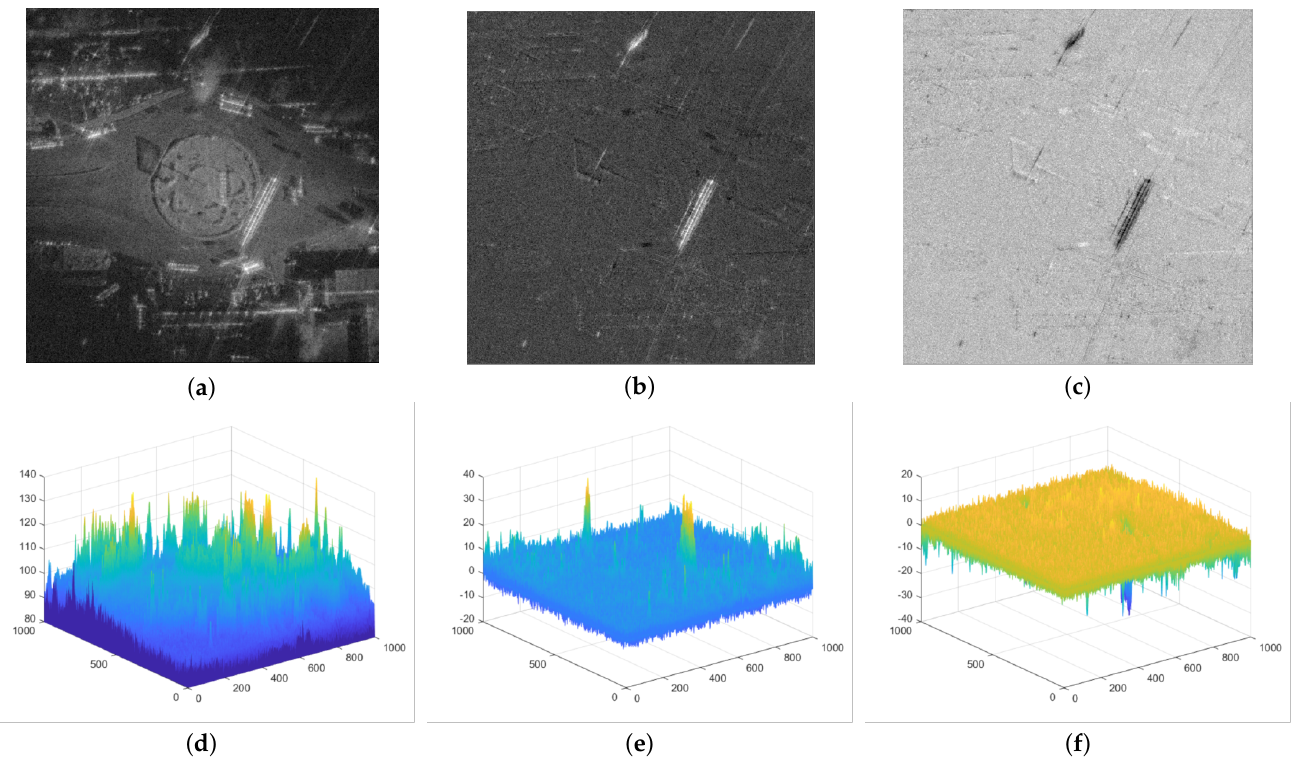
Figure 6. Intensity analysis of a moving target shadow. ( a – c ) The 17th image, the 17th foreground image, and the inverse of the 17th foreground image, respectively, and ( d – f ) their corresponding intensity